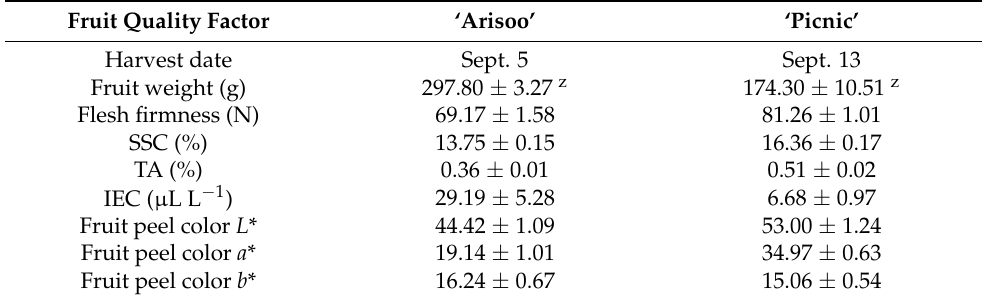
Table 1. Fruit quality attributes in ‘Arisoo’ and ‘Picnic’ at harvest. Fruit Quality Factor ‘Arisoo’